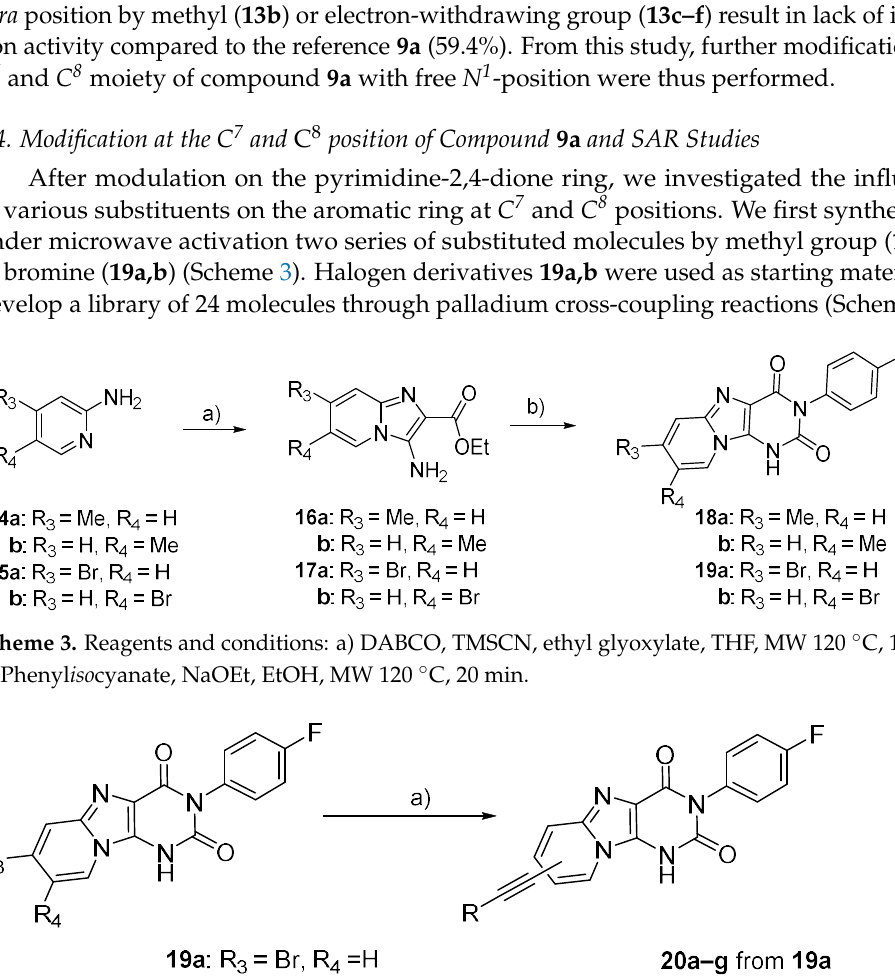
Table 4. Mtb ThyX inhibition at 200 µ M by the NADPH oxidase assay of benzyl analogues 13a–f .